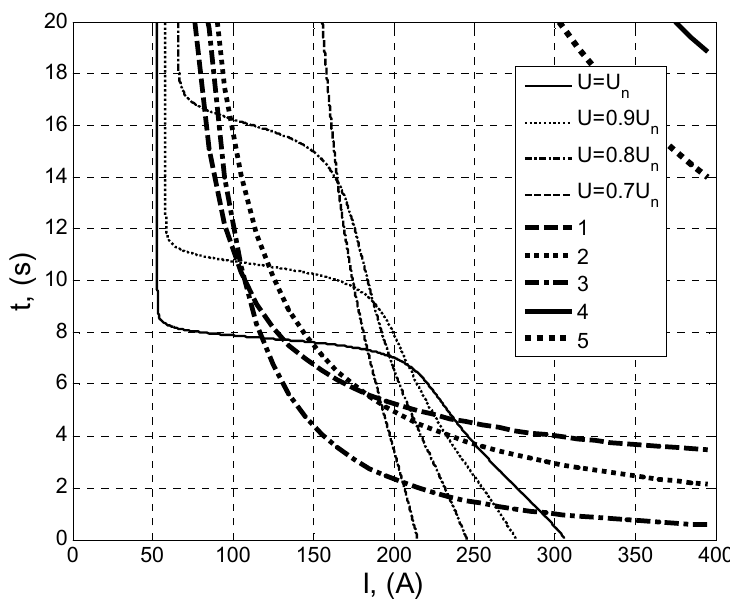
Figure 6. Courses of RMS value of stator current during its starting against the time-current characteristics of overcurrent protections with characteristics in accordance with Reference [4] and Invertim [16].